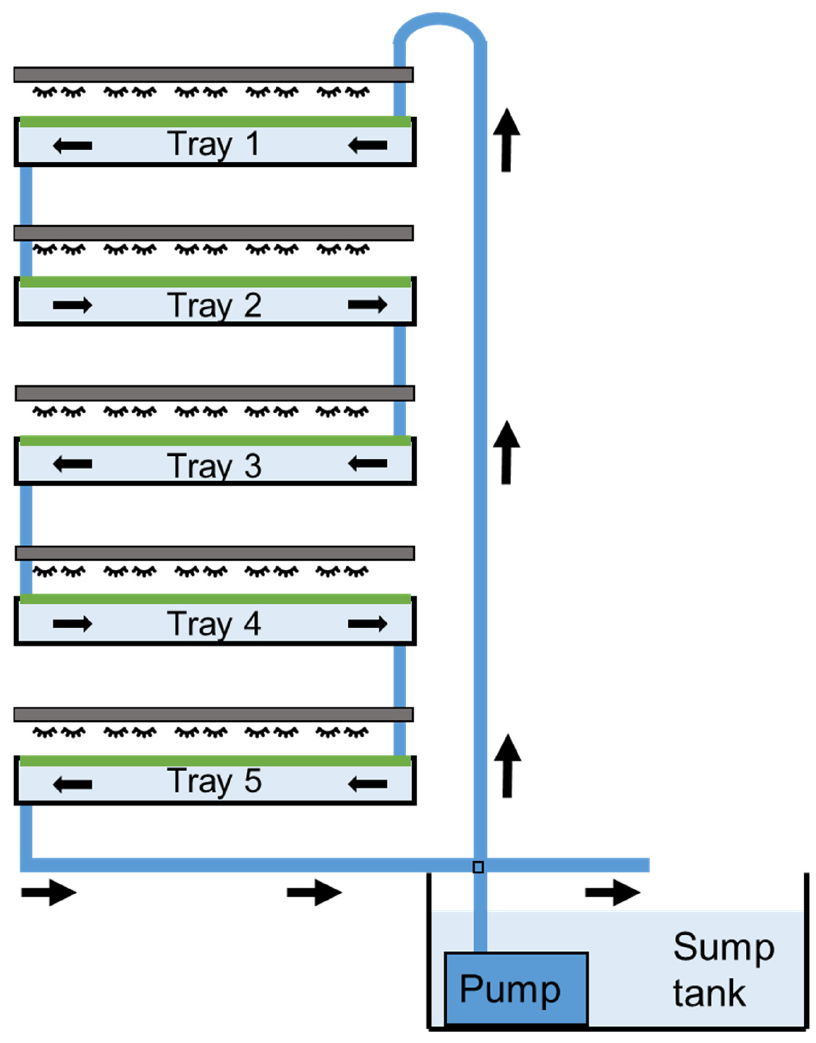
Figure 1. Schematic of the indoor, vertically stacked, 125-litre duckweed cultivation system. Table 1. Treatment combinations of flow rates (0.5, 1.5 or 3.0 L min − 1 ) and medium depths (25 mm or 50 mm). Calculated system velocities are shown.